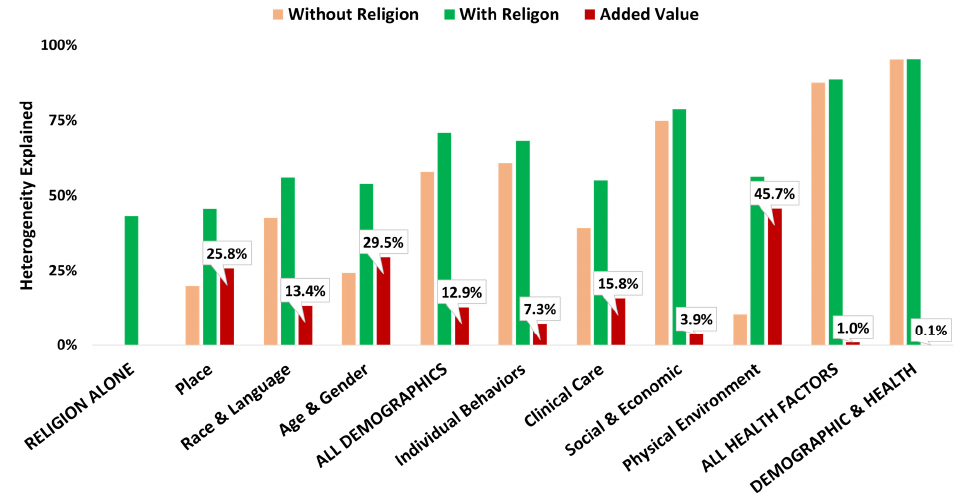
Figure 3. Religion Added Value.